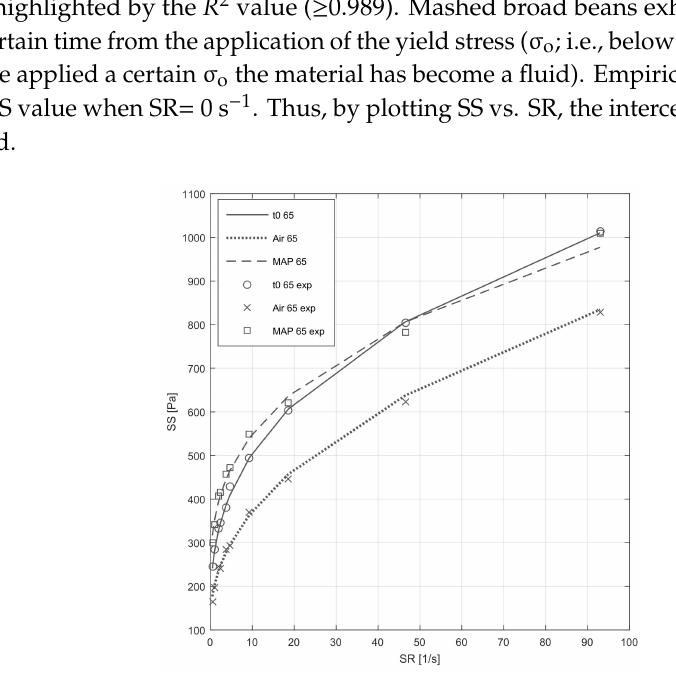
Figure 2. Rheogram of the fresh mashed broad beans at day 0 (t0) and after 7 days of cold storage, in air or MAP. The continuous lines represent the forecasts of the Hershel-Bulkley model, while the symbols are the experimental data